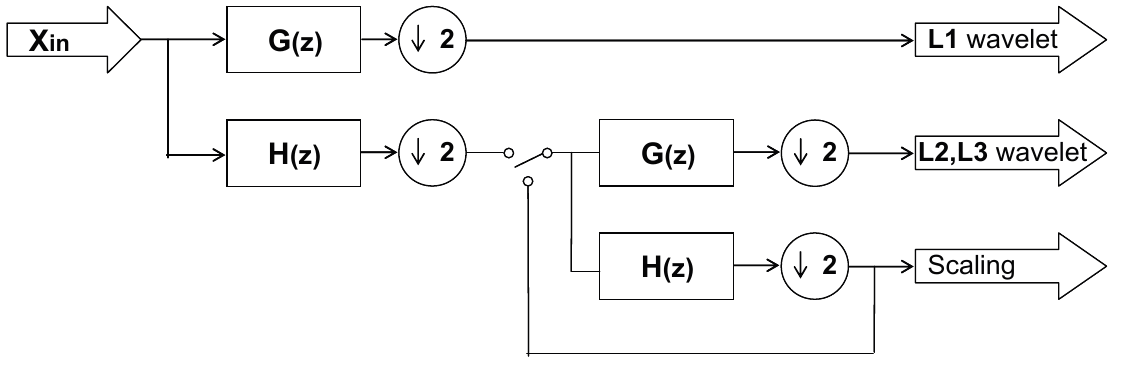
Figure 2. A three level 1D DWT structure as developed in